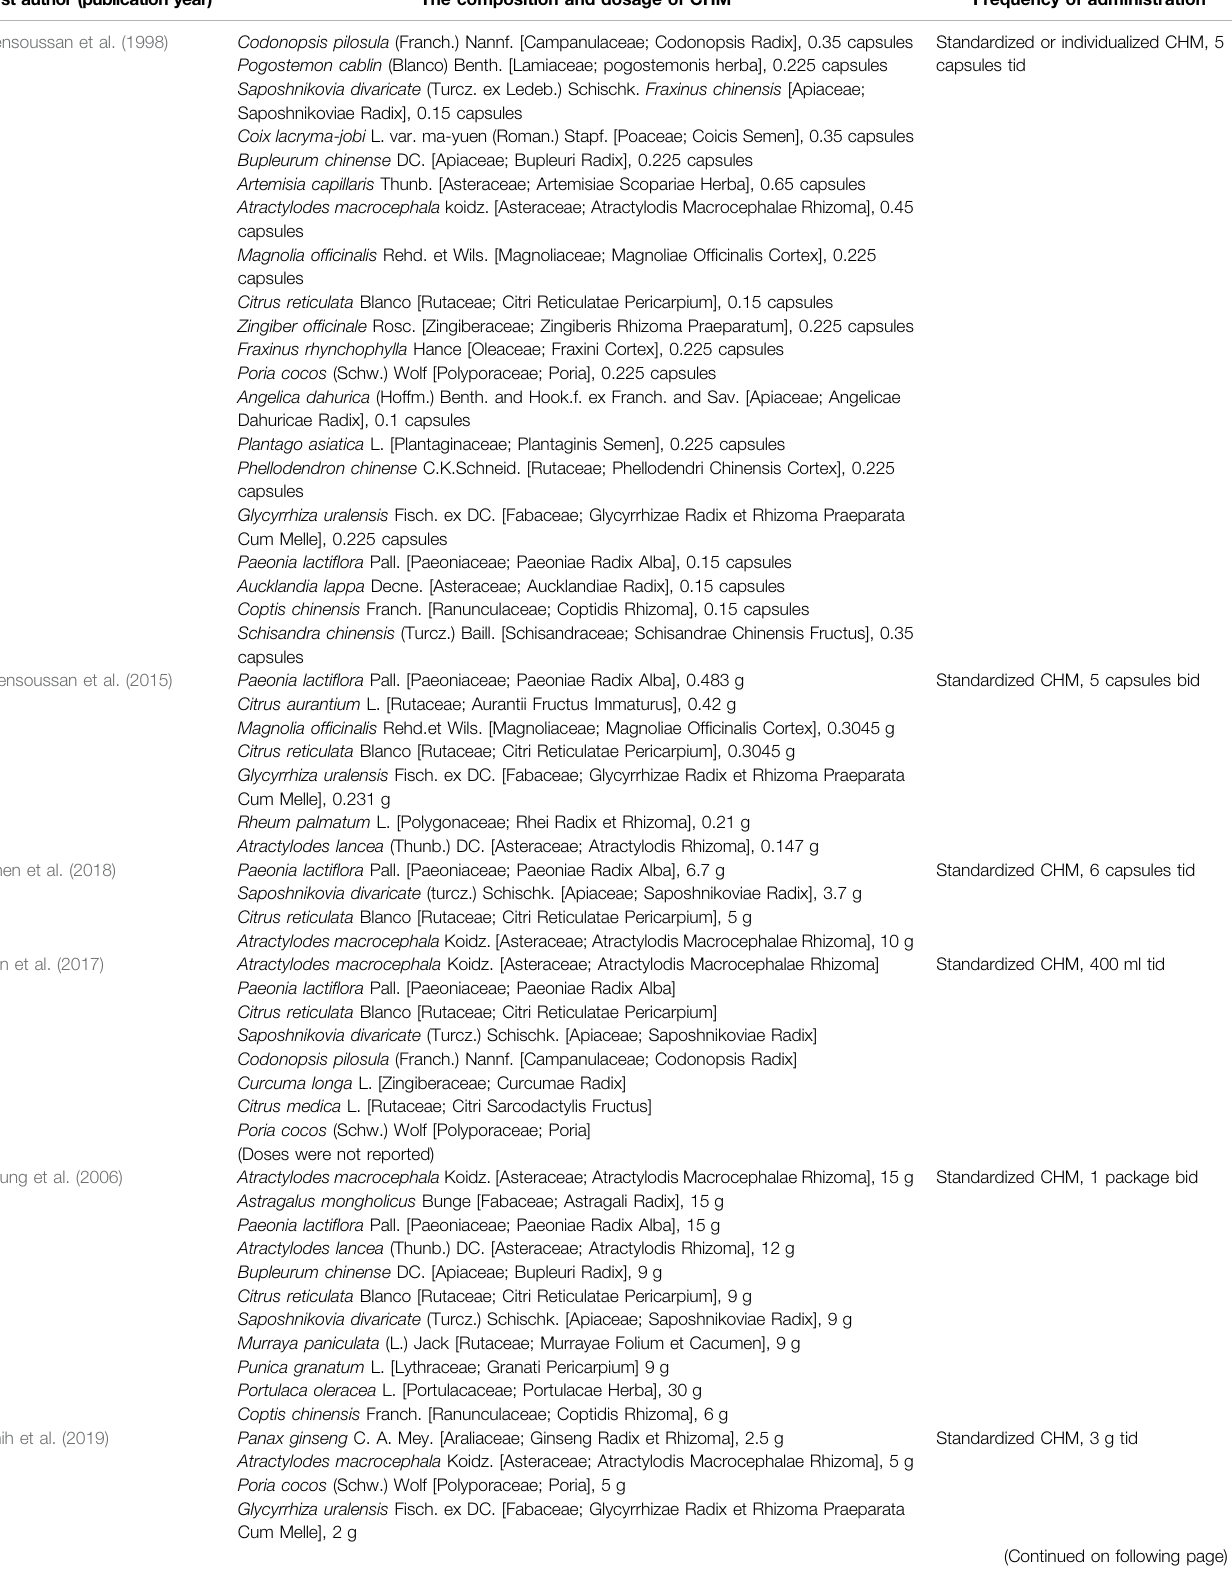
TABLE 2 | The composition and dosage of CHM reported in each